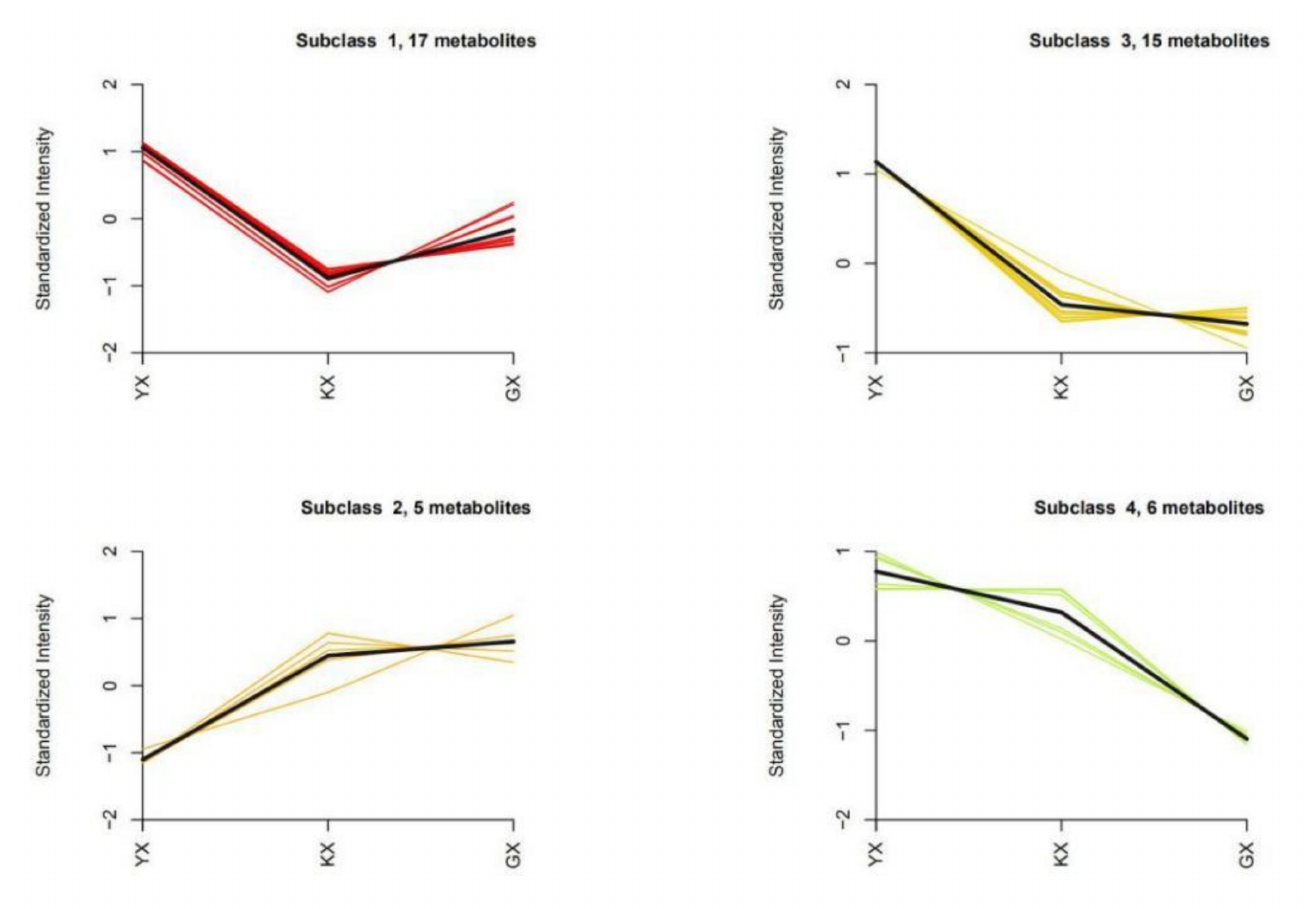
Figure 6. K-means map of four subclasses of differential